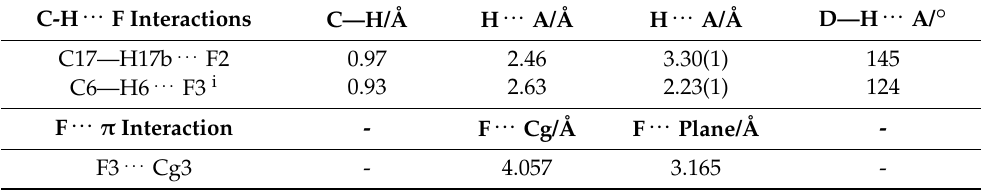
Table 3. Geometrical parameters characterizing the selected intermolecular interactions in structure I